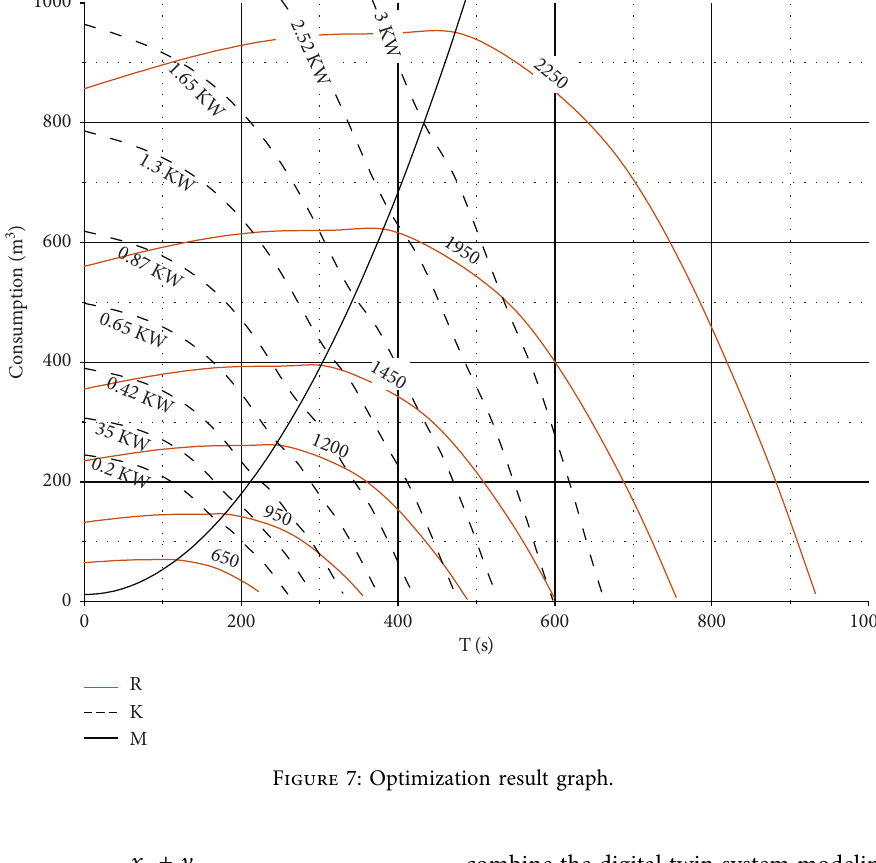
Figure 7: Optimization result